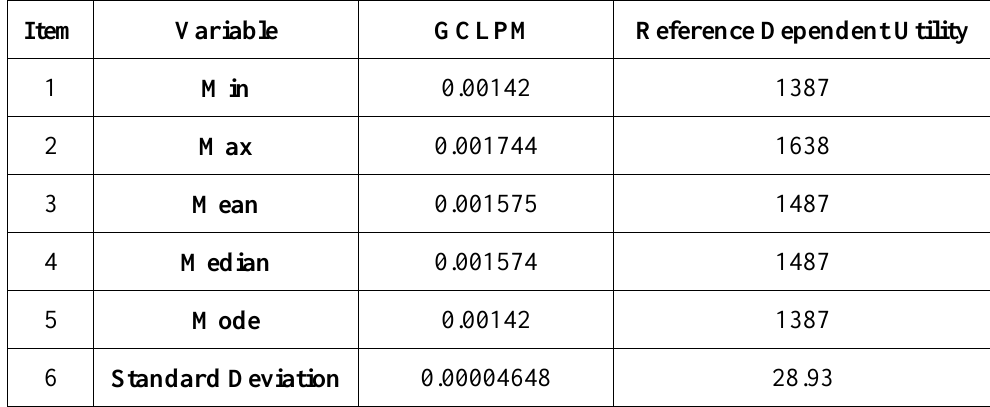
Table 3. Result Specification of Scenario 1 in First